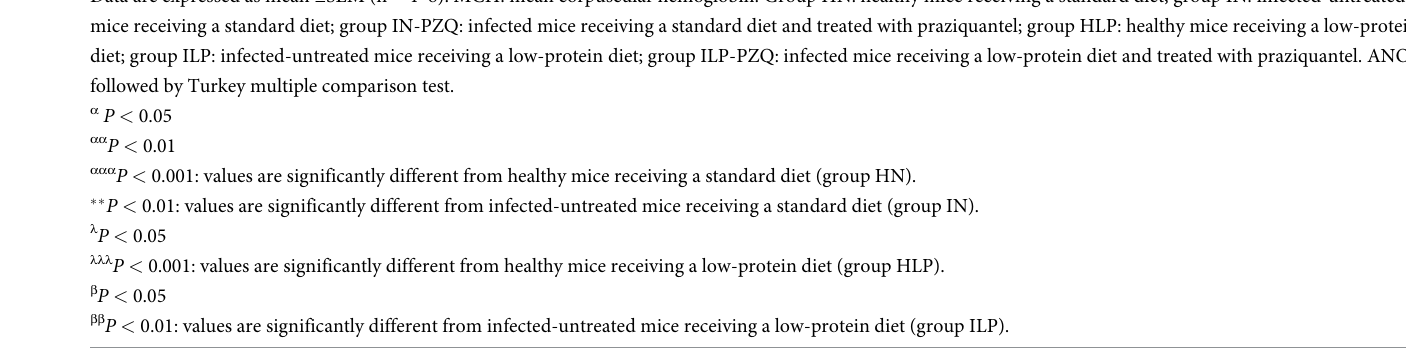
Data are expressed as mean ± SEM (n = 4–8). MCH: mean corpuscular hemoglobin. Group HN: healthy mice receiving a standard diet; group IN: